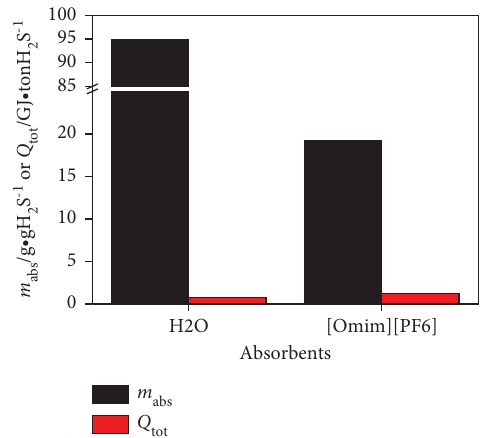
Figure 12: Te comparison of the performances of physical ab- sorbents for the H 2 S stream.